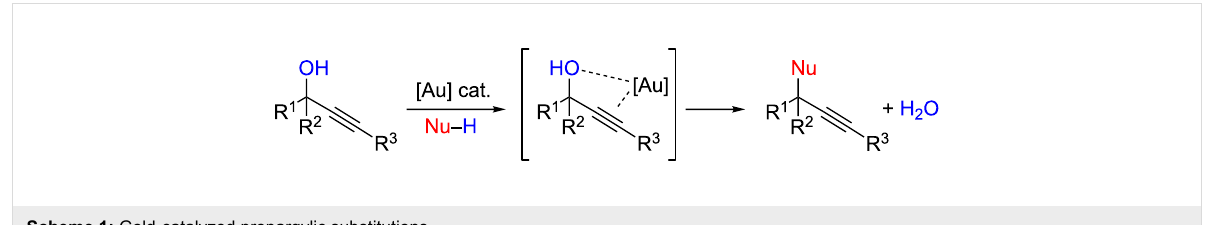
Scheme 1: Gold-catalyzed propargylic